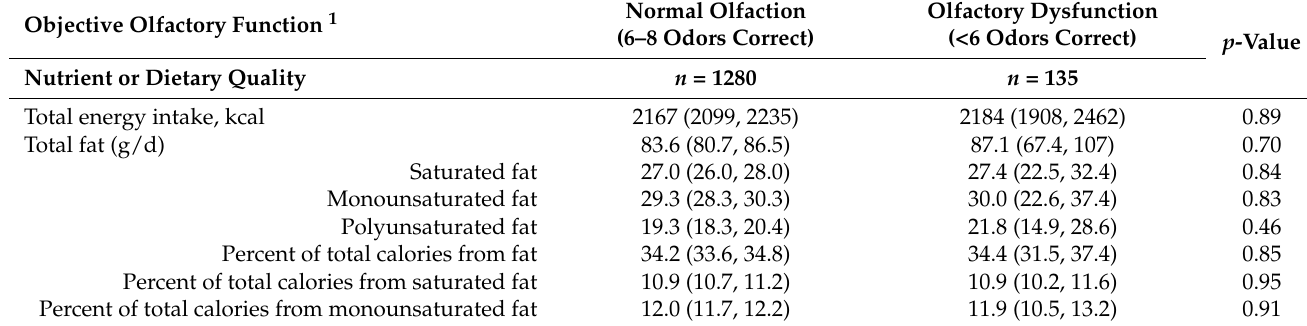
Table 2. Mean (95% CI) dietary intake by objective olfactory function among U.S. adults > 40 years in NHANES 2013–2014.